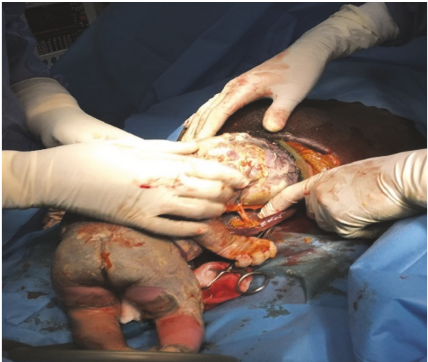
Figure 1: Umbilical cord being removed from the fetal neck.